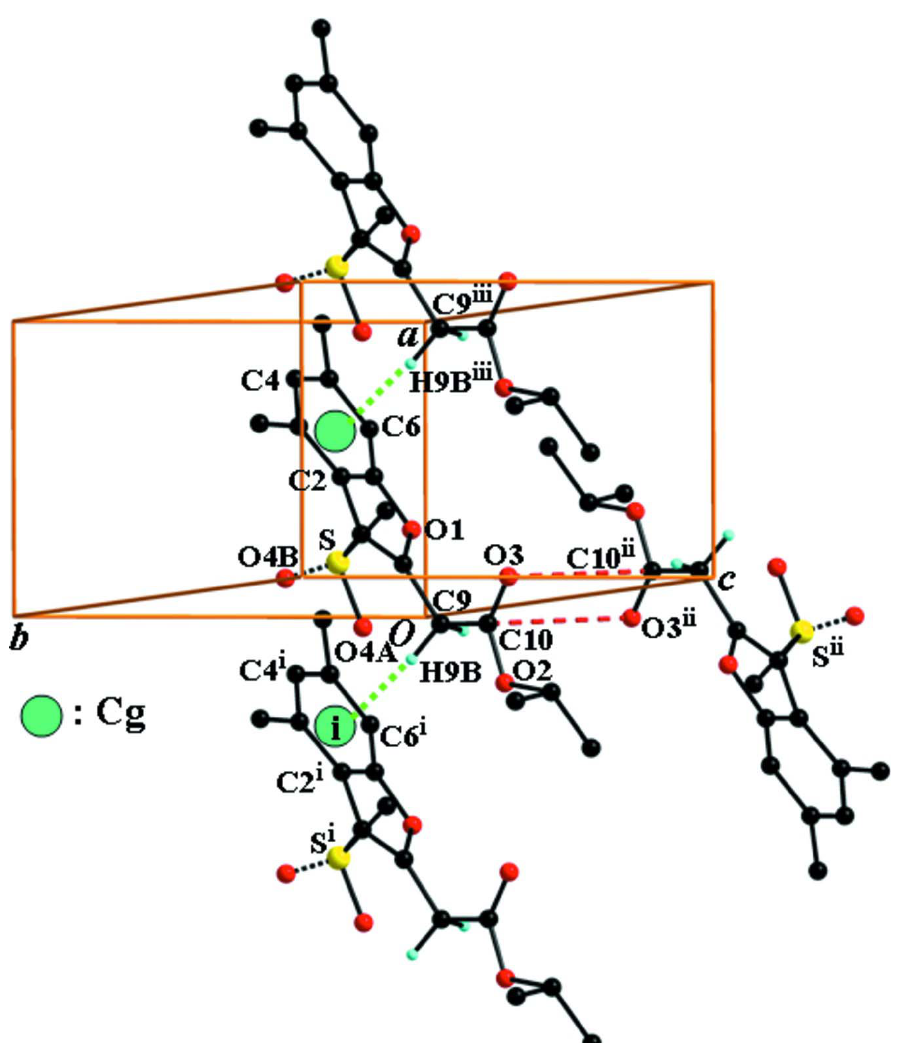
C—H··· π and C···O interactions (dotted lines) in the title compound. Cg denotes ring centroid. [Symmetry code: (i) x - 1, y , z ; (ii) - x , - y , - z + 1; (iii) x + 1, y , z